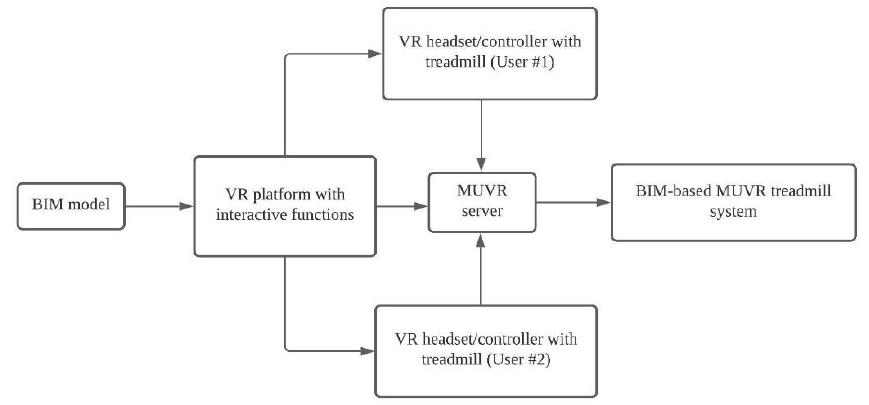
Figure 1. Framework of the BIM-based MUVR omnidirectional treadmill system.